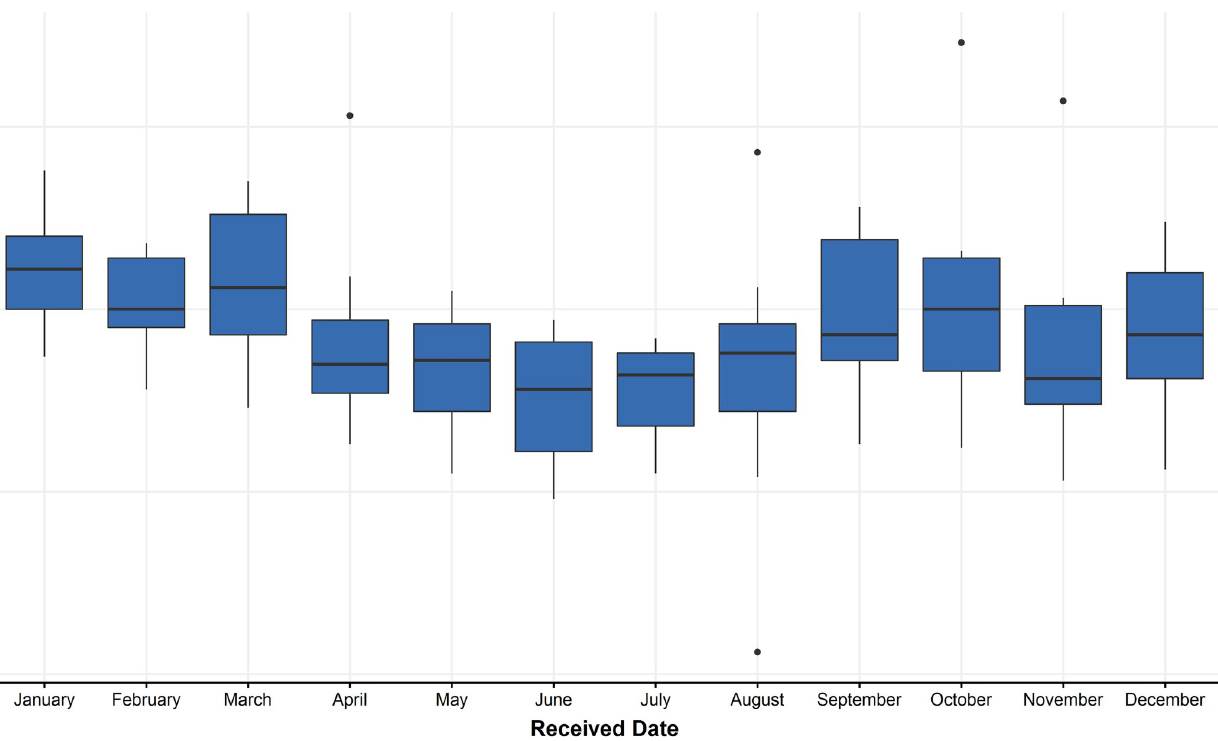
PLOS ONE | https://doi.org/10.1371/journal.pone.0228105 February 5,